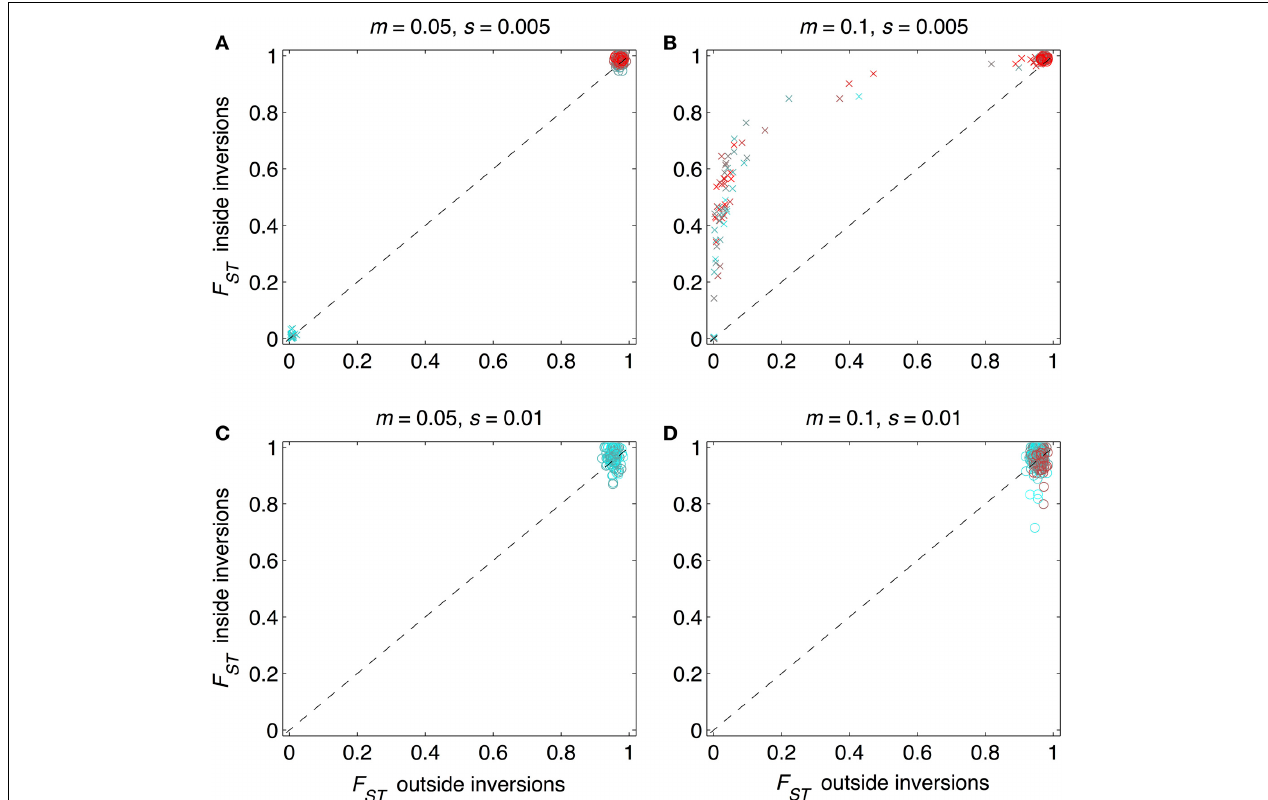
FIGURE 2 | Mean F ST values for loci within and outside inverted regions for 984 simulation runs. Circles show runs in which divergence reached a designated barrier strength, m / m e ≥ 500; “x” symbols show runs that did not reach this barrier strength within the allotted time (1,200,000 mutations and generations). Periods of allopatry were varied in steps of 1000 generations. As colors change from cyan to red, the period of allopatry changes, respectively, from zero to as long as 50,000 generations (when red symbols